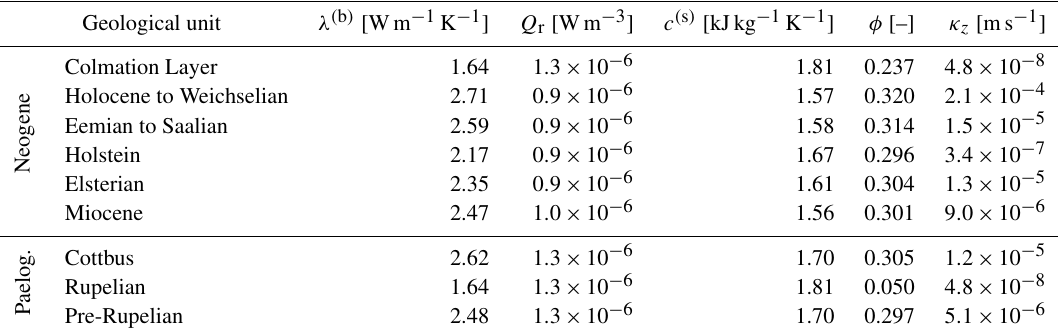
Table 1. Properties of the geological units as used for the calculations. Properties of Cretaceous and older units after Sippel et al. (2013). c ( s ) = heat capacity of solid, φ = porosity, κ = hydraulic conductivity, Q r = radiogenic heat production, λ ( b ) = bulk thermal conductivity; Values were derived from Otto (2012), VDI (2010), Norden and Förster (2006), Norden et al. (2012), Das (2013), Devlin (2015) and Sippel et al.